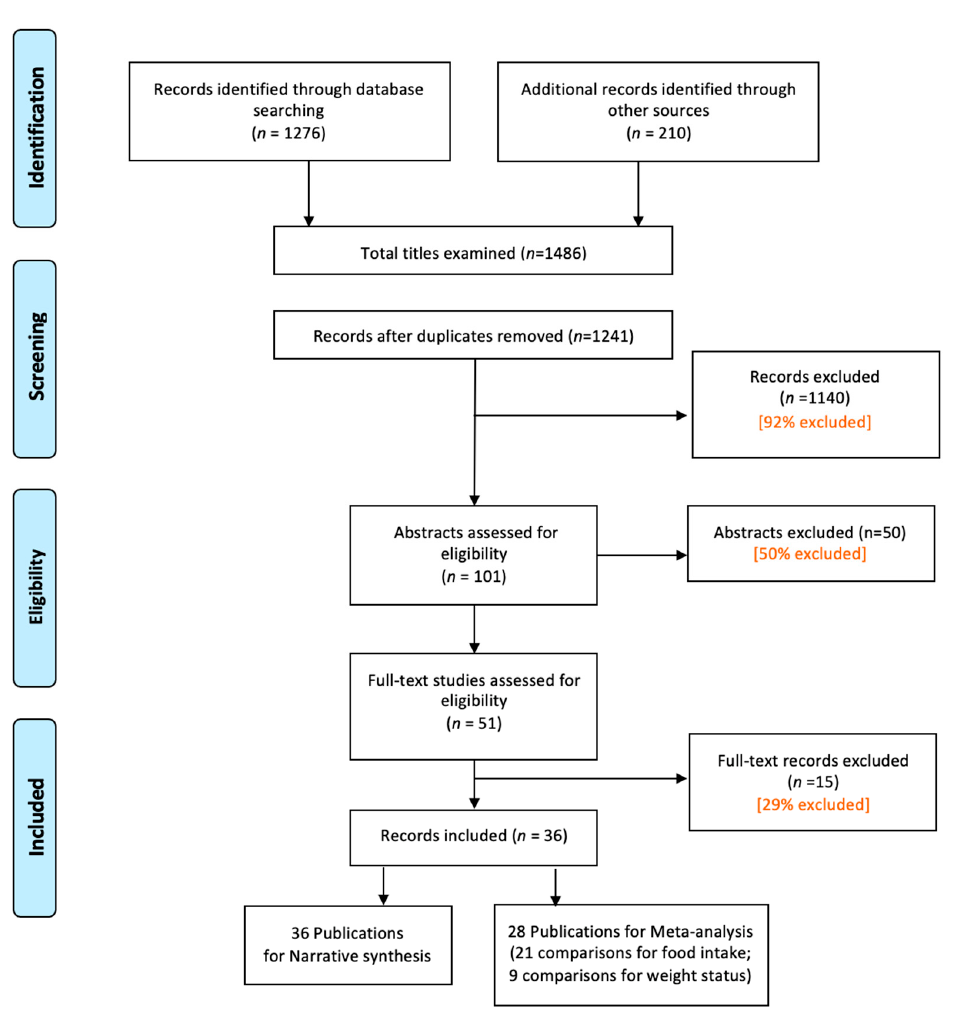
Figure 1. PRISMA Flow diagram for study inclusion (based on [34]).